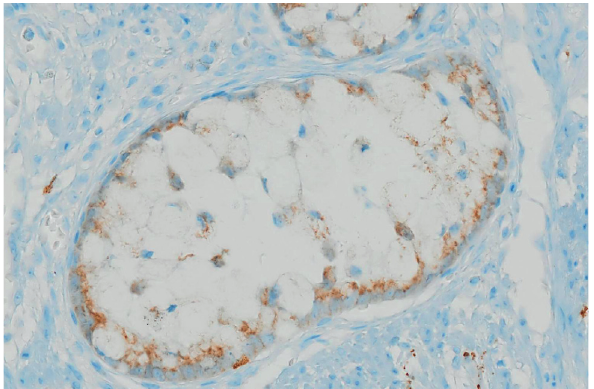
Fig. 4. Isolated cells of adenocarcinoma ex-goblet cell carcinoid positively react with an antibody against chromogranin (chro- mogranin, 200x).